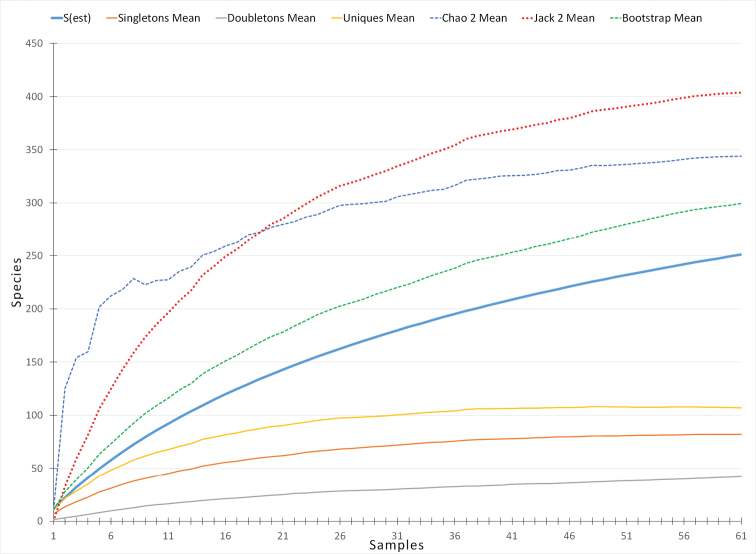
Species accumulation curves (EstimateS, Vesrion 9.1.0.). Three nonparametric estimators (Chao 2, Jackknife 2 and Bootstrap) of total species richness are calculated. S(est) is the cumulative number of species observed.